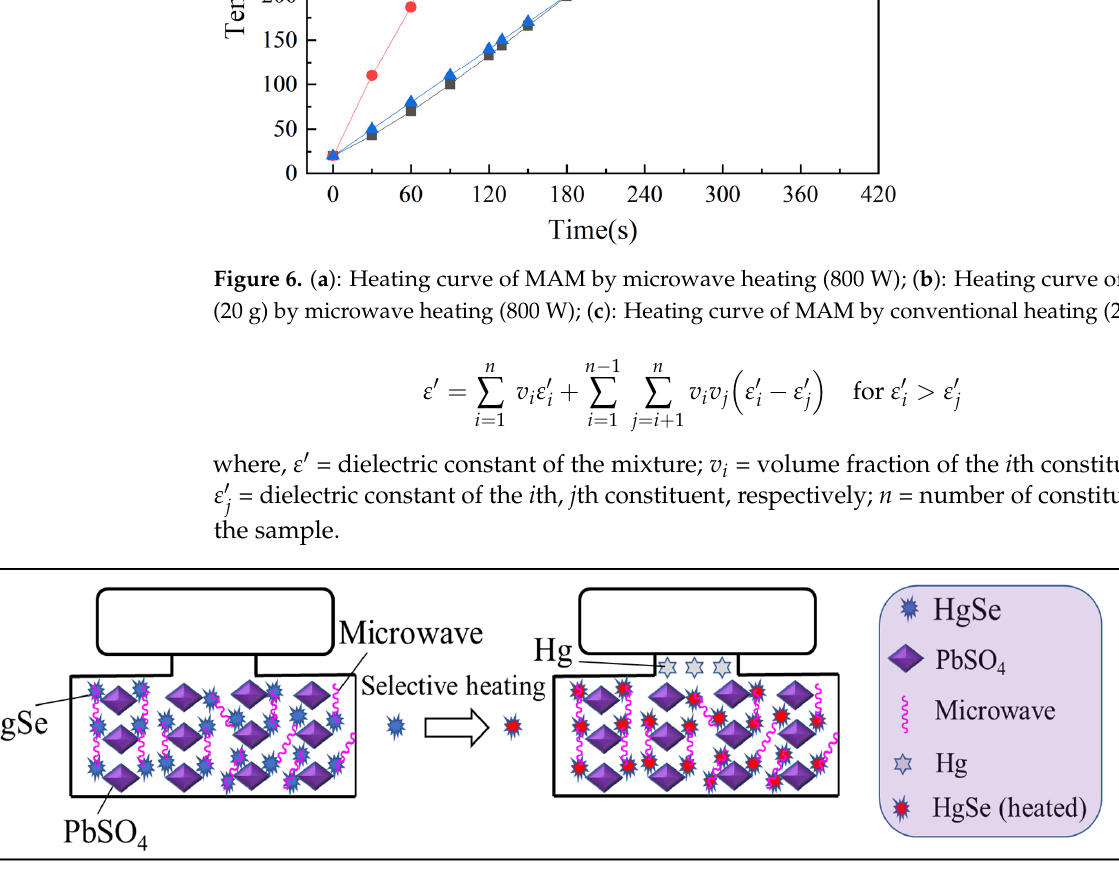
Figure 7. Mechanism diagram of the recovery of mercury from MAM by microwave heating.